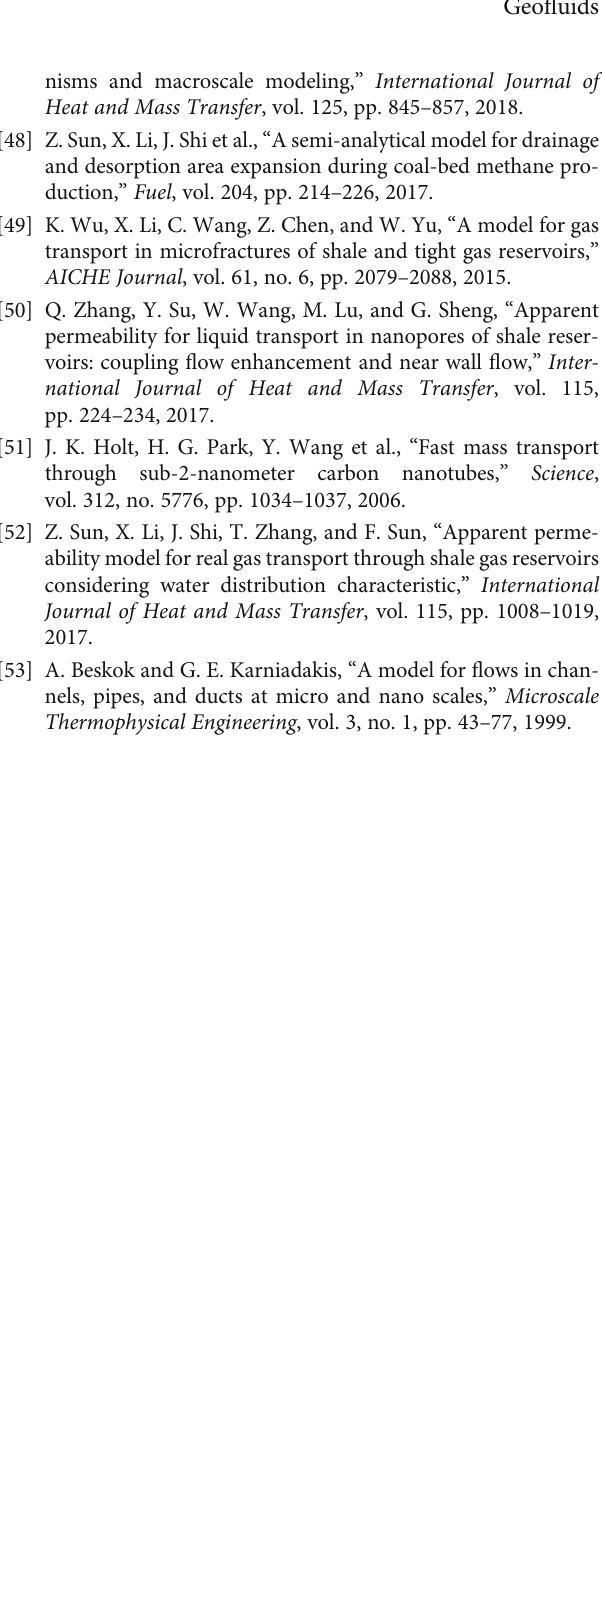
e ff ect on nanocon fi ned water fl ow, ” Proceedings of the